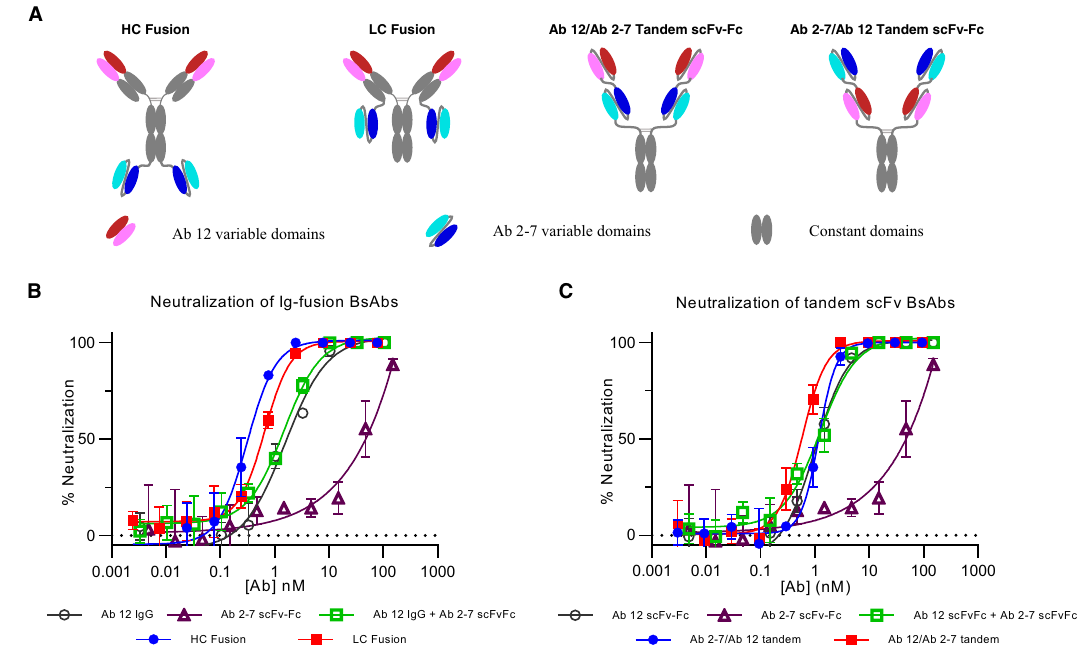
Fig.5|Designandinvitrocharacterizationofanti-SARS-CoV-2BsAbs.A Design ofthefouranti-SARS-CoV-2BsAbs.Constantregionsarecoloredingray,Ab12binding domains are red/pink, and Ab 2-7 binding domains are blue/cyan. In vitro